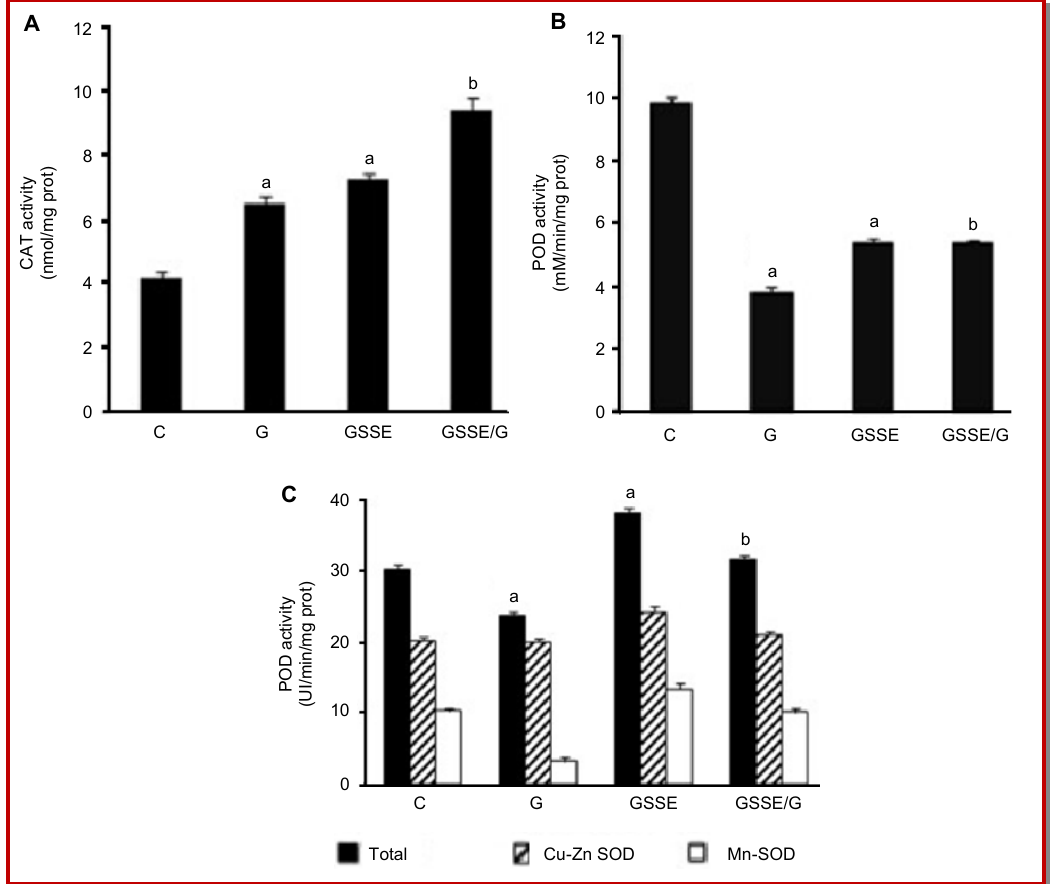
Figure 3: Effect of garlic and GSSE on kidney anti-oxidant enzyme activities. Rats were daily administered with 10% ethanol (C), garlic (G), grape seed and skin extract (GSSE) or garlic plus GSSE (GSSE/G) for 1 month and kidney catalase (A), peroxidase (B) and superoxide dismutase (C) activities were determined. Results are expressed by mean ± SEM (n= 10). a p<0.01 vs C. b p<0.01 vs